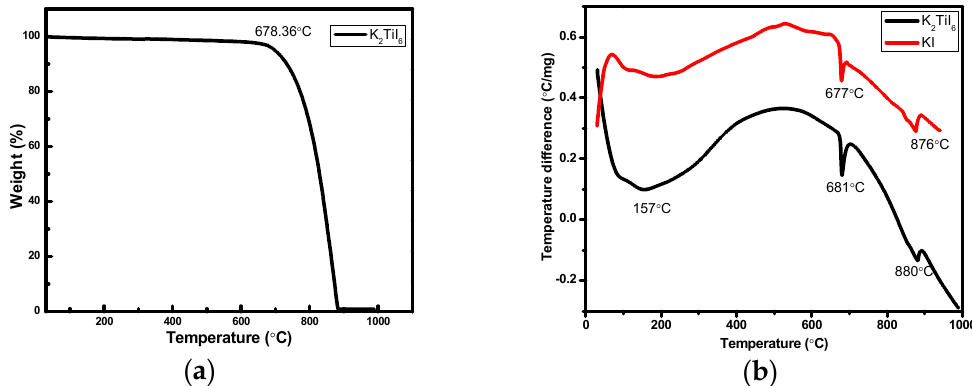
Figure 6. ( a ) Thermogravimetric analysis of K 2 TiI 6 ; ( b ) Differential thermal analysis of K 2 TiI 6 and